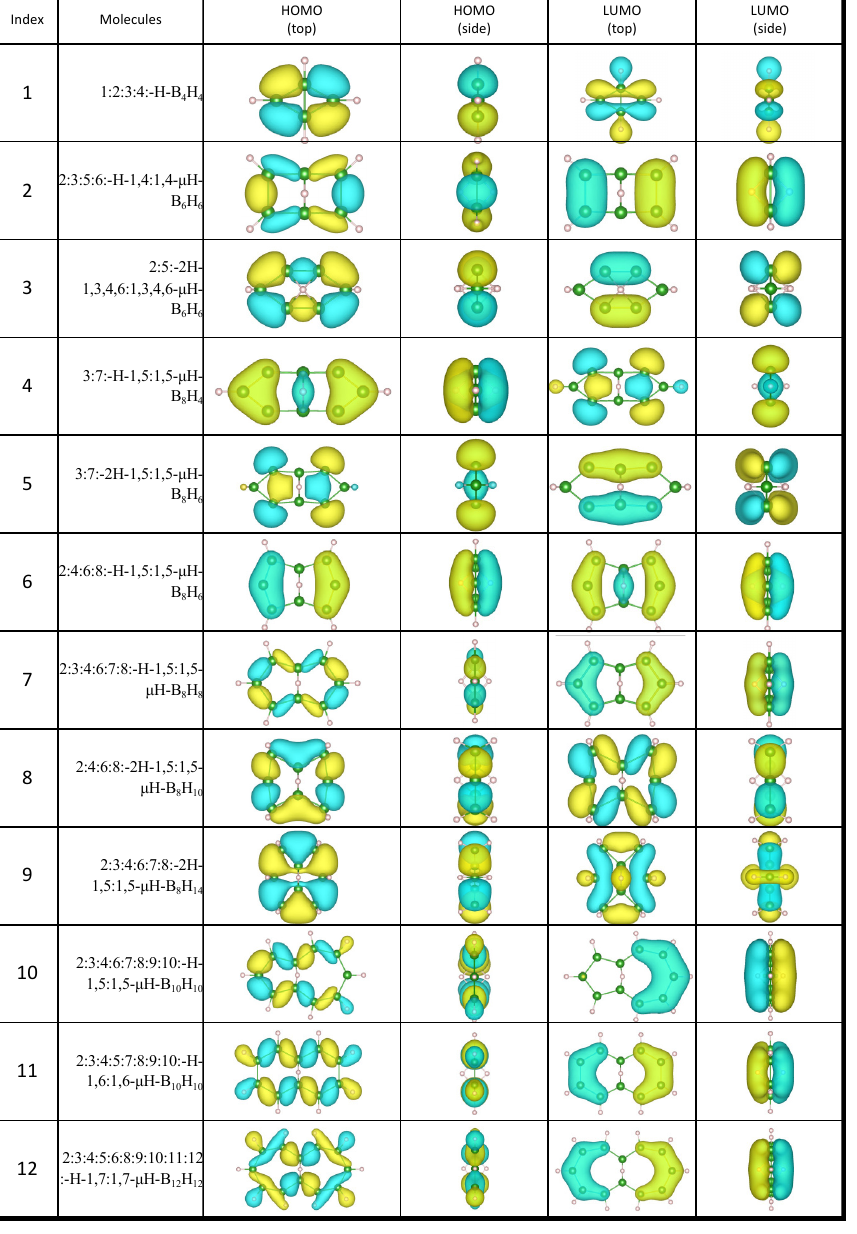
Figure A1. Candidates for the cyclic hydrogenated boron molecules. The structures are overlapped with molecular orbitals of HOMOs and LUMOs. The color of each molecular orbitals corresponds to the sign of its wave functions.